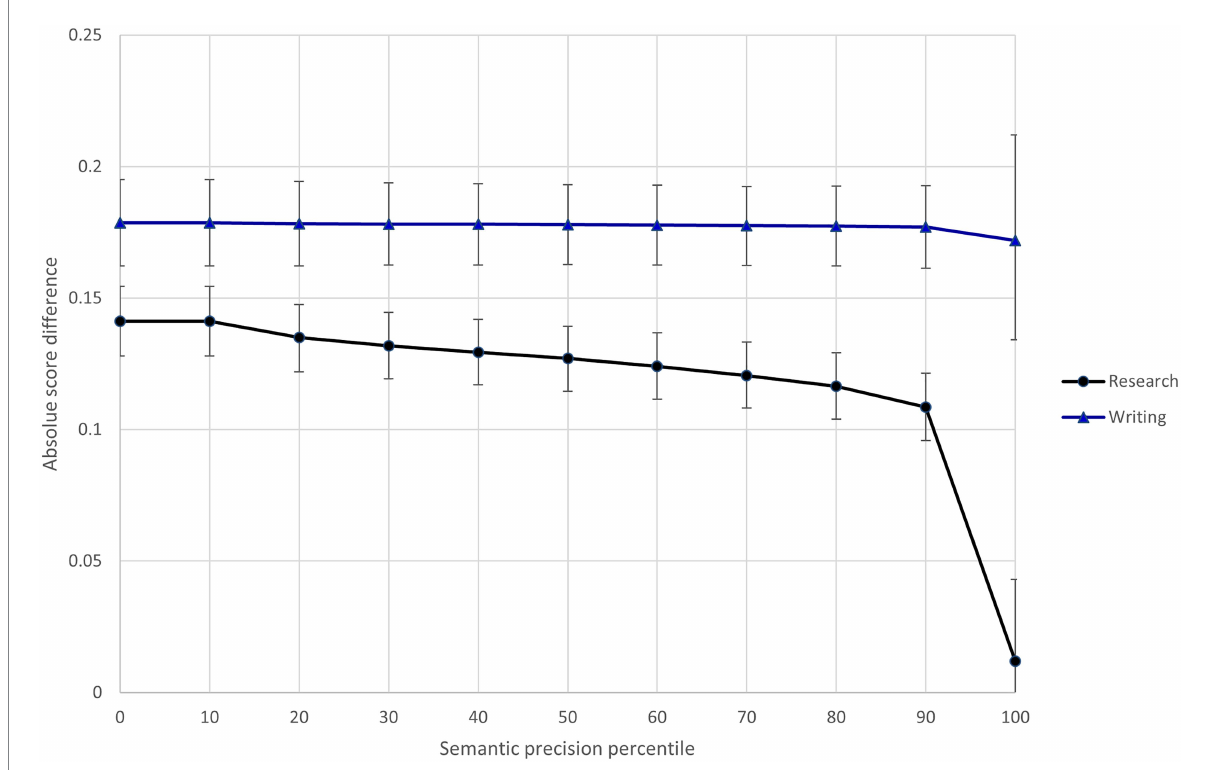
FIGURE 5 Differential influence of response semantic precision on difficulty of scoring research and writing